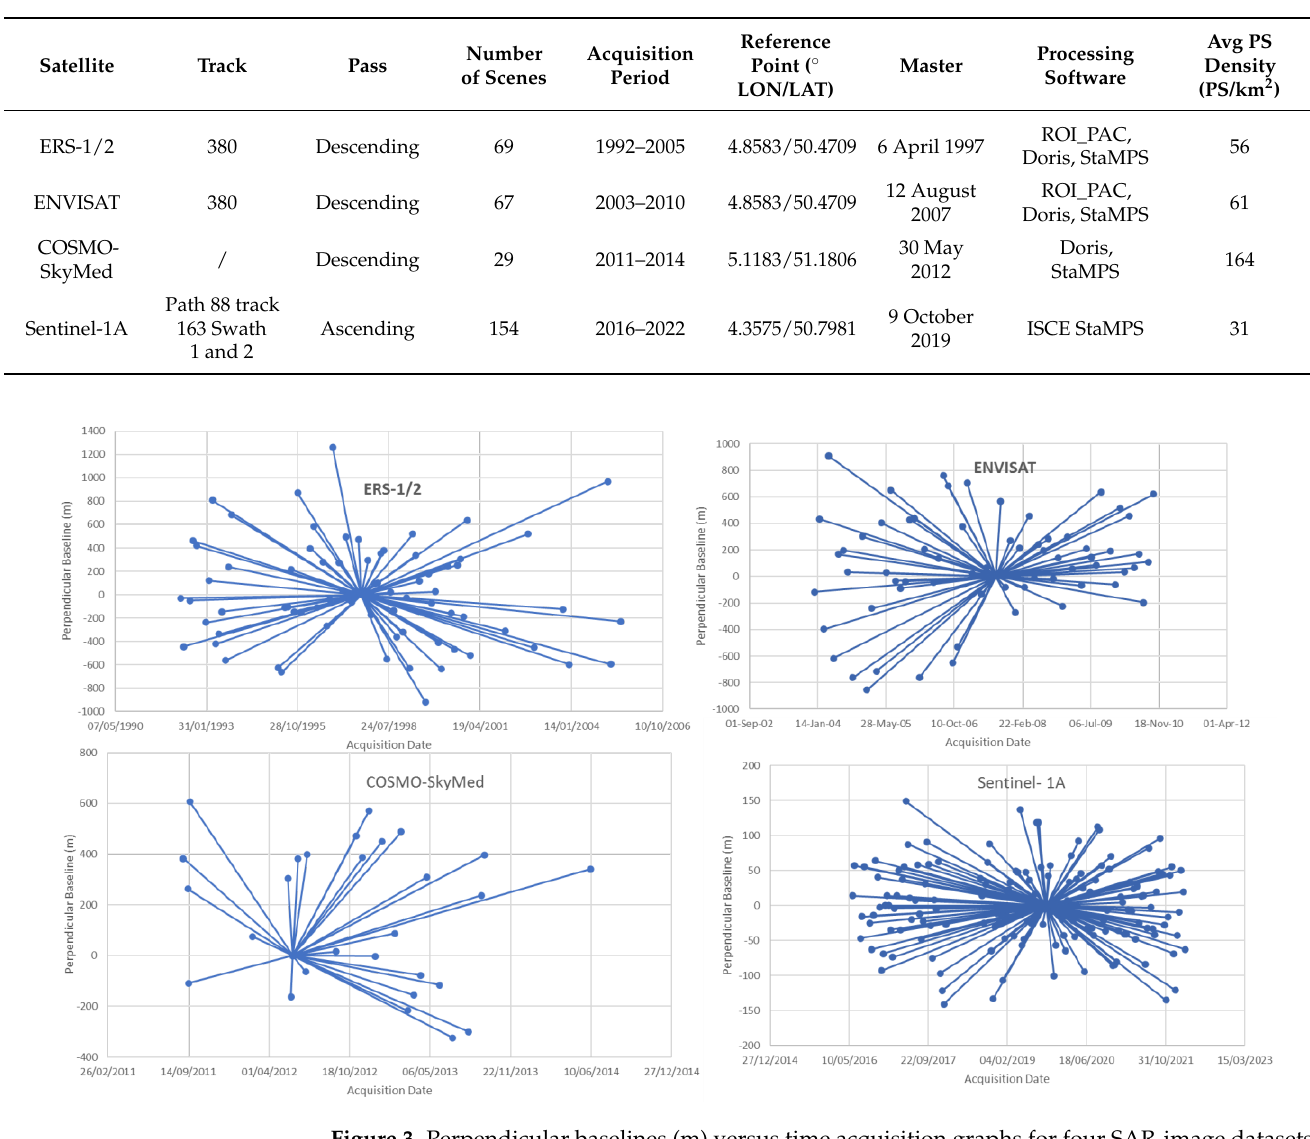
Figure 3. Perpendicular baselines (m) versus time acquisition graphs for four SAR-image datasets covering the periods of ERS1/2, ENVISAT, COSMO-SkyMed, and